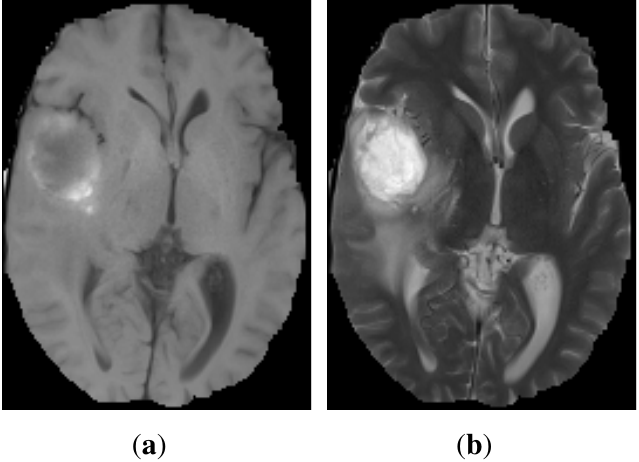
Figure 1. Example of multimodal images: T1 MR ( a ) and T2 MR ( b ) scans of a brain with a